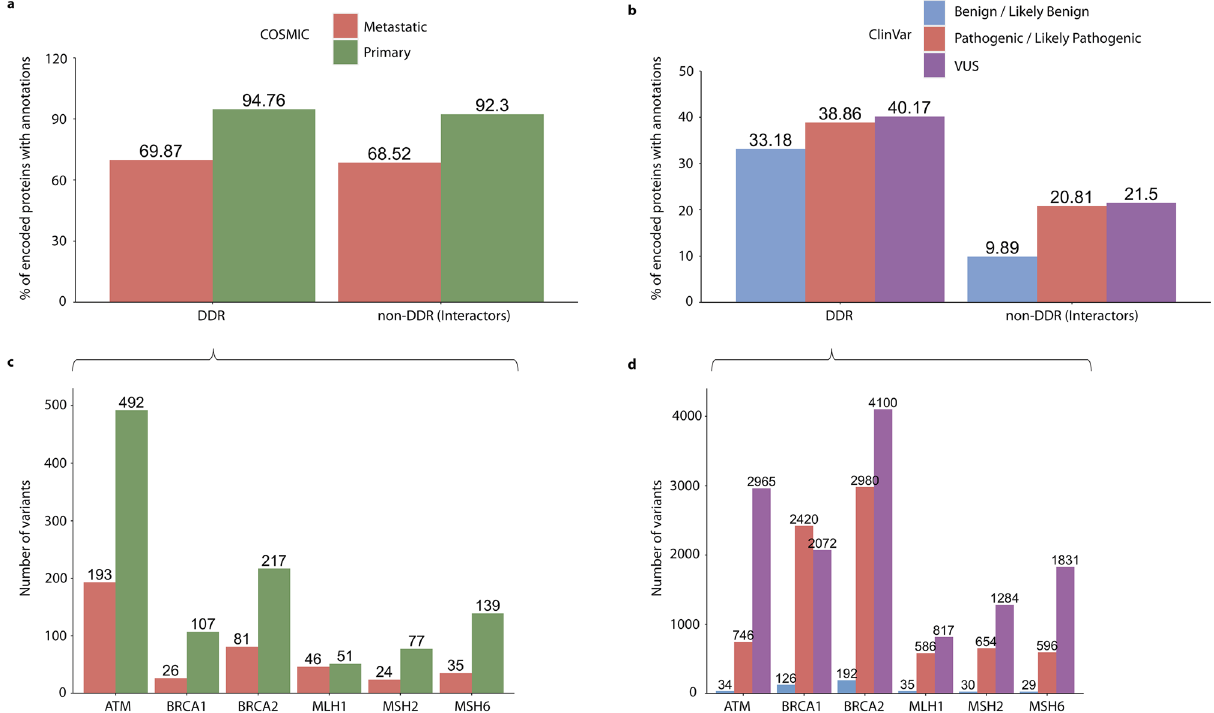
Figure 1. Accumulation of germline and recurrent somatic variants in DDR and non-DDR interactors in the NetDDR network. Percentages of protein-coding genes with variant annotations in COSMIC and ClinVar are shown in panels ( a , b ), respectively. Patterns of recurrent somatic (≥ 2 samples) and germline variants in the highly mutated DDR genes are illustrated in panels ( c , d ), respectively. An additional analysis of the variant distributions, normalized by protein length, is shown in Supplementary Fig.